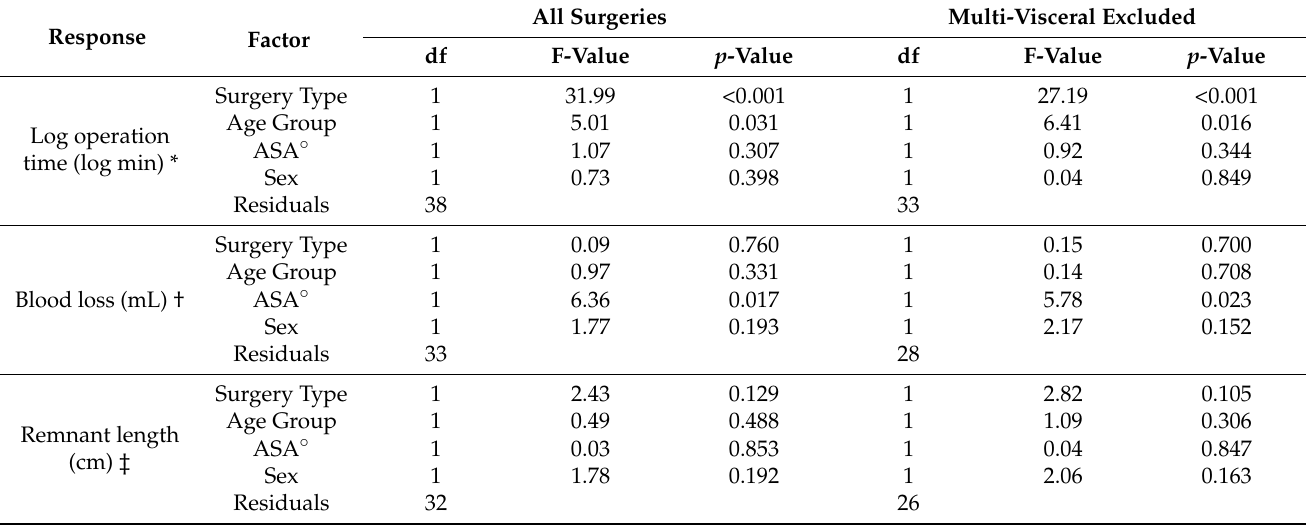
Table A4. Type III ANOVAs for the additive effects of surgery type (MPP or TP), age group (<65 or